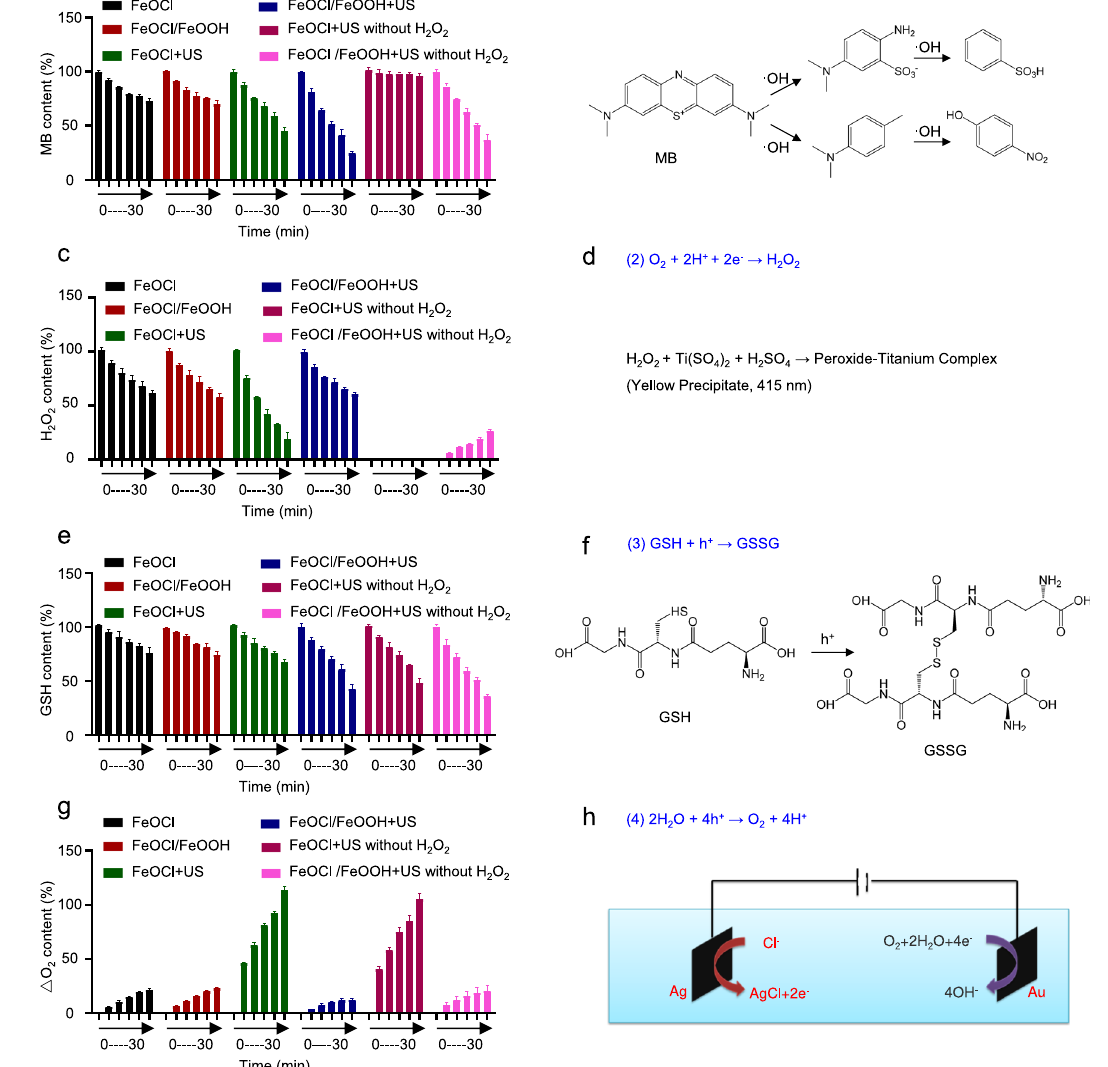
Fig. 4 Catalytic performance analysis of FeOCl NSs and FeOCl/FeOOH NSs. a , b The degradation of MB caused by FeOCl NSs and FeOCl/FeOOH NSs under different treatments. Data are presented as mean ± s.d. ( n = 3 independent experiments). c , d The change of H 2 O 2 caused by FeOCl NSs and FeOCl/ FeOOH NSs under different treatments. Data are presented as mean ± s.d. ( n = 3 independent experiments). e , f The degradation of GSH caused by FeOCl NSs and FeOCl/FeOOH NSs under different treatments. Data are presented as mean ± s.d. ( n = 3 independent experiments). g , h The generation of O 2 caused by FeOCl NSs and FeOCl/FeOOH NSs under different treatments. Data are presented as mean ± s.d. ( n = 3 independent experiments). The condition for US treatment is 1 MHz, 1 W cm − 2 , 50% duty cycle. Source data are provided as a Source Data fi